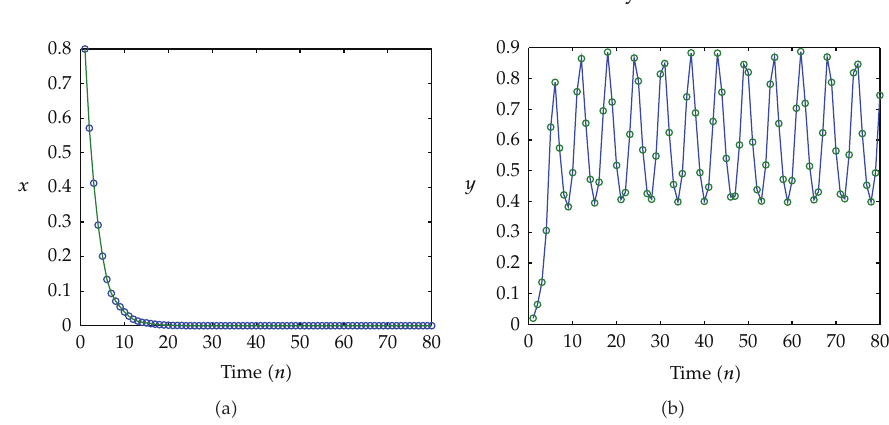
Figure 3: Dynamics behavior of system (cid:4) 4.5 (cid:5) with initial condition (cid:4) x (cid:4) 0 (cid:5) ,y (cid:4) 0 (cid:5)(cid:5) (cid:8) (cid:4) 0 . 8 , 0 . 02 (cid:5)